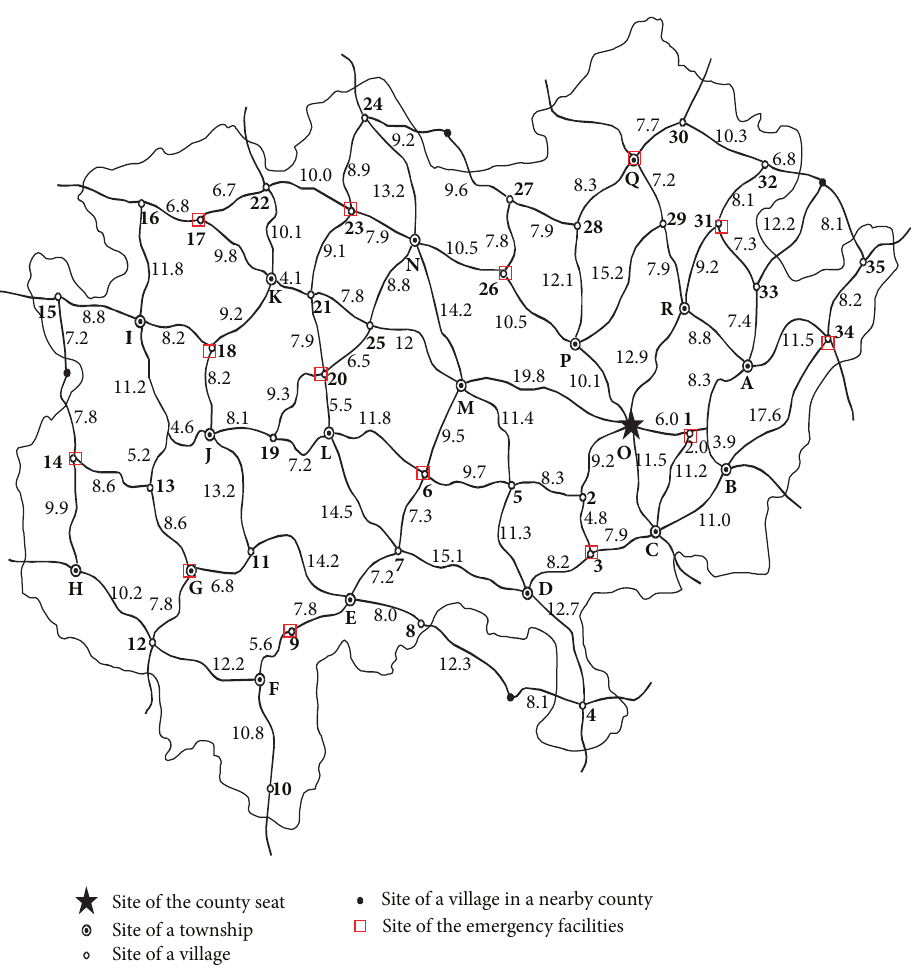
Figure 3: Locations of the emergency facilities in the case study with a maximum time